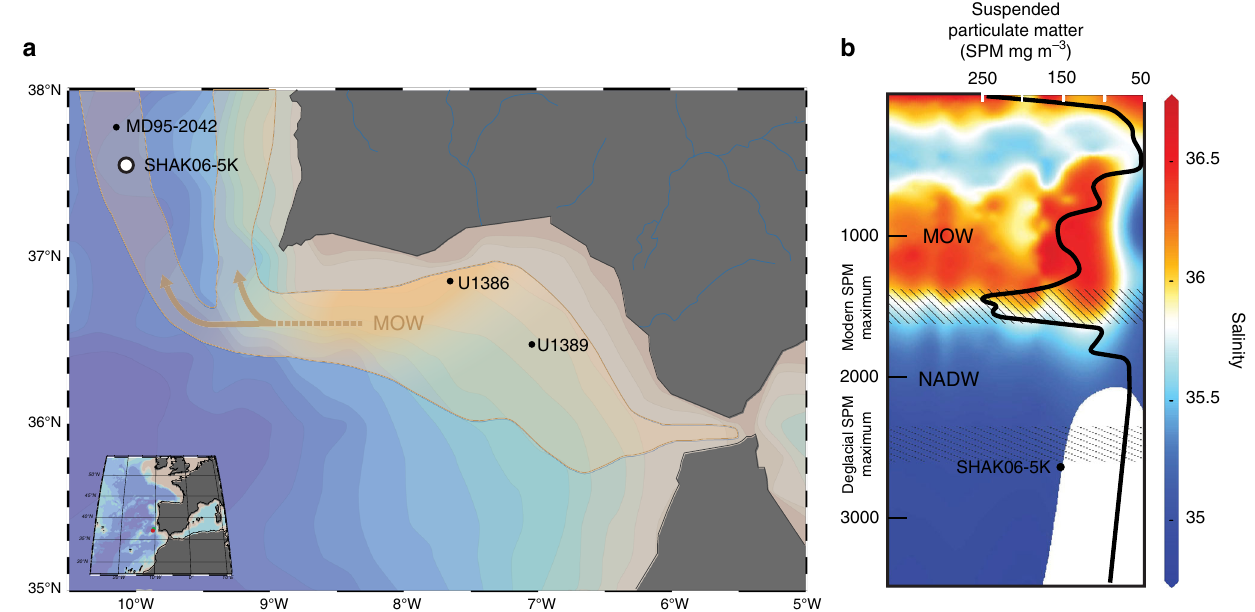
Fig. 1 Core sites and down-column water chemistry pro fi les. Maps of the southwest Iberian margin ( a ) showing modern ocean current trajectories of Mediterranean out fl ow water (MOW [shown in orange]), which fl ows around 500 – 2000 m depth, and locations of SHAK06-5K (open circle) and MD95- 2042, U1386, and U1389 (black dots). Orange arrows show approximate sediment transfer courses out of the Gulf of Cadiz 9,61,65,84 . Bathymetric contours are shown at 50 m intervals as adapted from Ocean Data View (Schlitzer, R. Ocean Data View, odv.awi.de, 2018). b , Contemporary pro fi le around 37.5 °N for salinity, which correlates with seawater density 50 . Also shown are estimates of the modern (solid hatches) and deglacial (stipled hashes) nepheloid layer mixing (peak) depths 16,17,50,84 , which are re fl ected by particulate-matter concentration maxima. Deglacial nepheloid layer depths are derived from numeric simulations 50,84 considered together with complementary grain-size, isotopic and foraminiferal data regarding glacial MOW dynamics 3,8,50 .